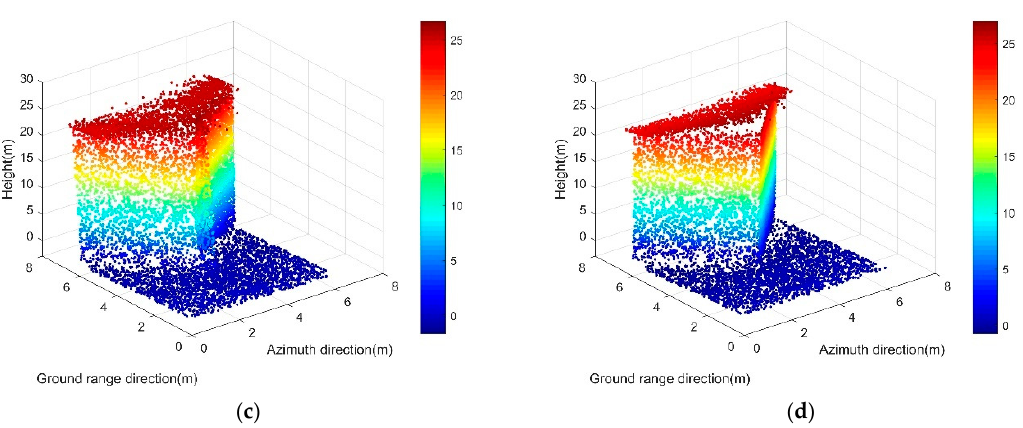
Figure 15. Results on the simulated data of the building corner. ( a ) Original simulated point clouds from one side looking. ( b ) Results of our proposed method; ( c ) Results of the RANSAC algorithm; ( d ) Results of the TomoSeed algorithm.